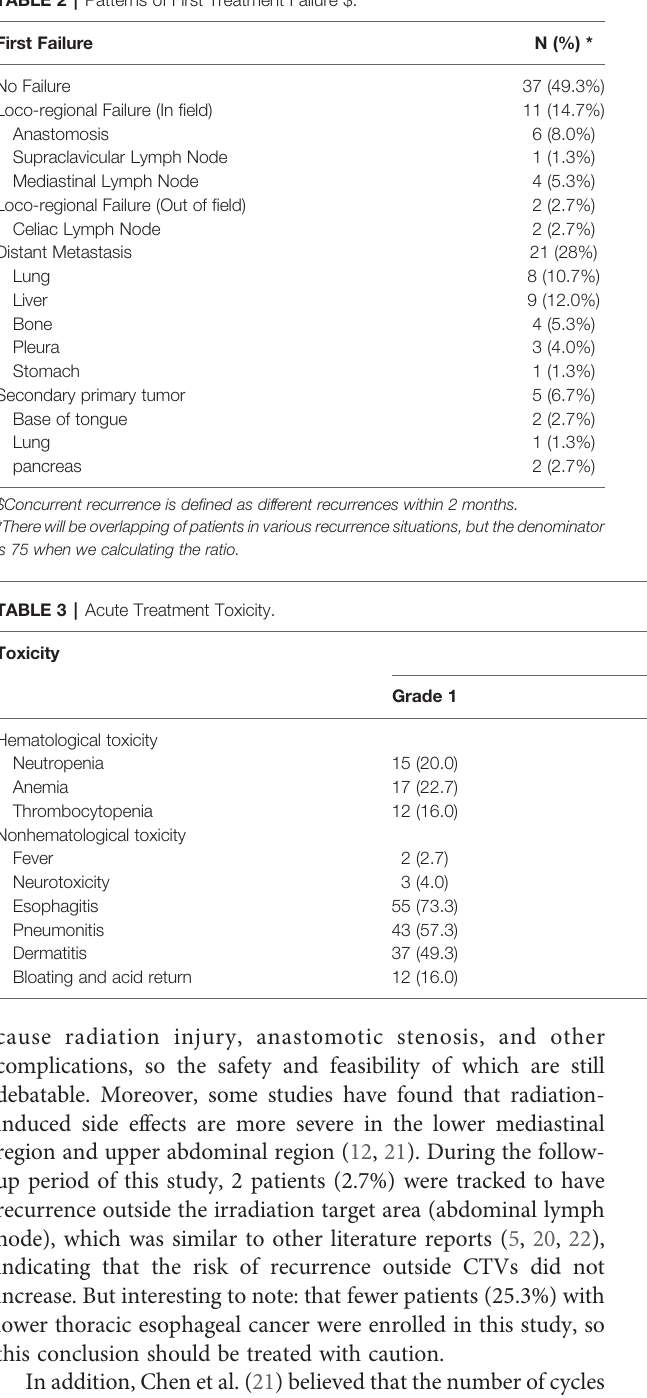
TABLE 2 | Patterns of First Treatment Failure